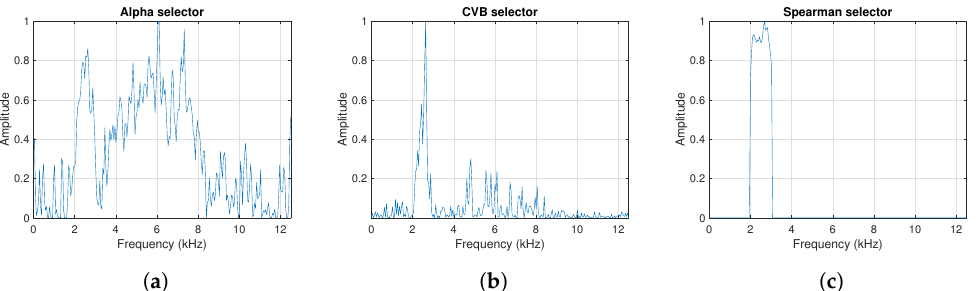
Figure 4. The considered informative frequency band (IFB) selectors for the simulated signal s 1 . ( a ) Alpha selector. ( b ) CVB selector. ( c ) Spearman